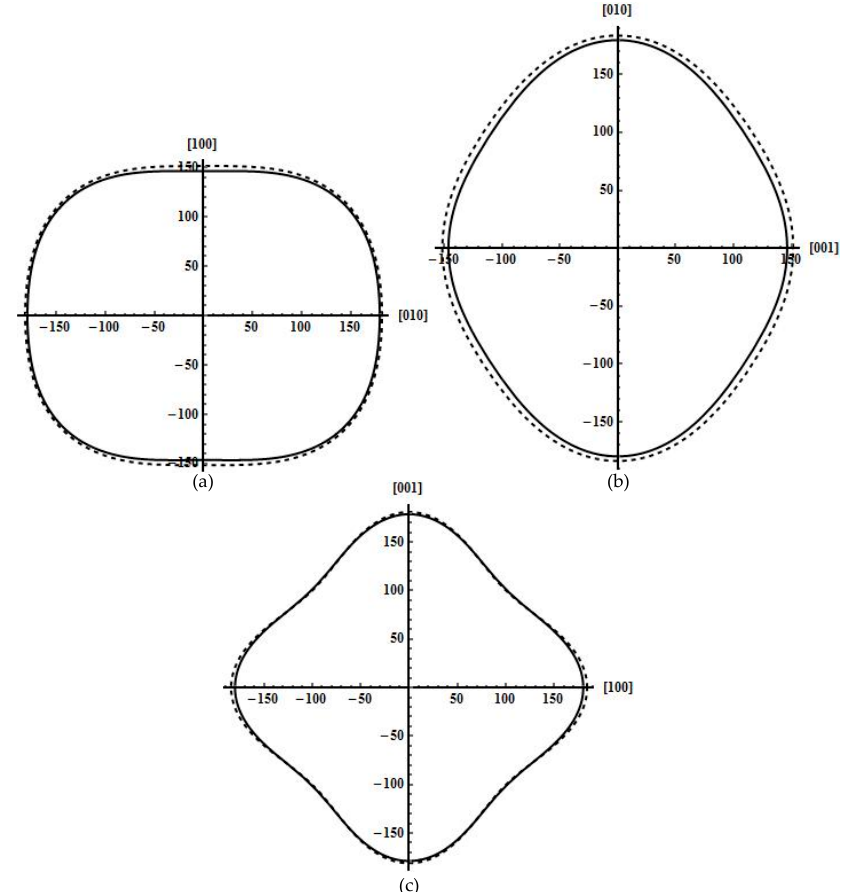
Figure 2. The orientation dependent Young’s modulus of B19 TiAl in the ab plane ( a ) with the tensile axis rotated from [100] to [010], the bc plane ( b ) with the tensile axis rotated from [010] to [001], and the ca plane ( c ) with the tensile axis rotated from [001] to [100]. The solid and dashed lines represent the calculated values of the energy density and the strain–stress methods, respectively.